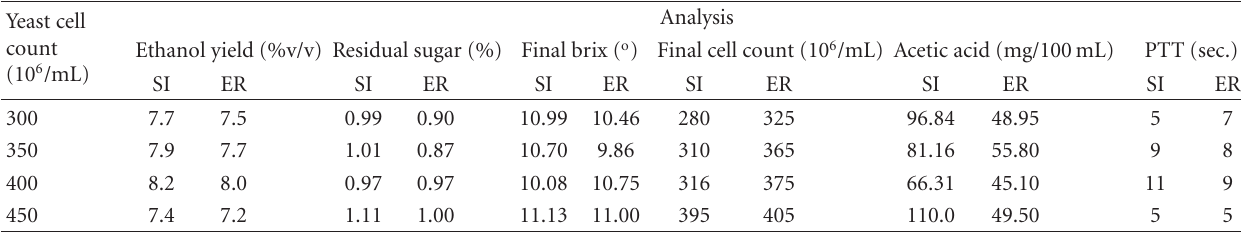
∗ SI: Saf-Instant and ER: Ethanol Red. Table 2: Table 1 E ff ect of varying concentrations of urea (as nitrogen source) on ethanol and acetic acid production by two commercial strains ∗ of yeast on sugarcane molasses in fed-batch cultures.